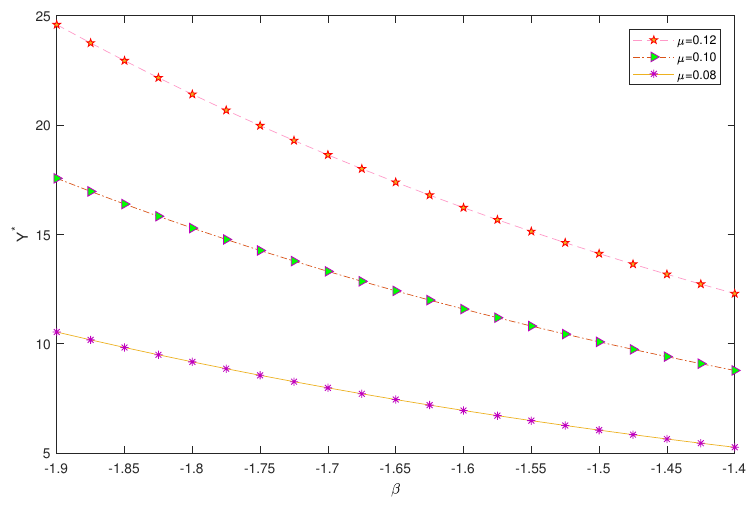
Figure 5. Influence of β and µ on Y ∗